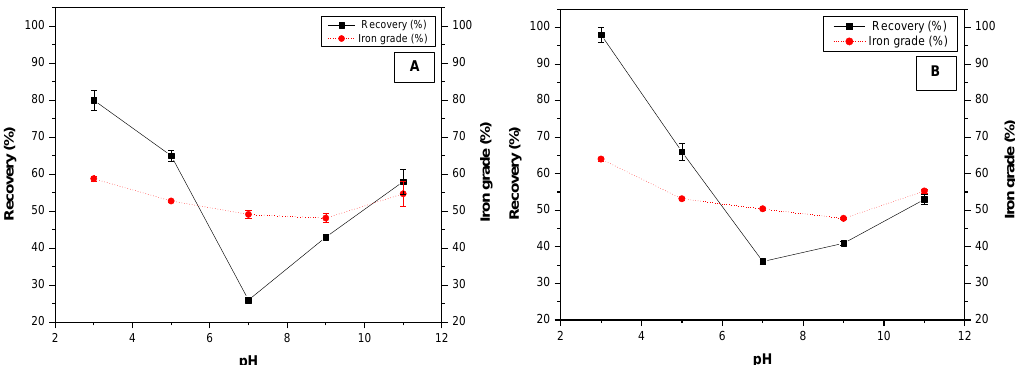
Figure 9. Electroflotation of iron ore as a function of pH. Current density 16 mA/cm 2 , [biosurfactant]: 300 mg/L; agitation: 300 rpm. ( A ): Particle size ˗ 38 + 20 µm. ( B ): Particle size − 20 µm.